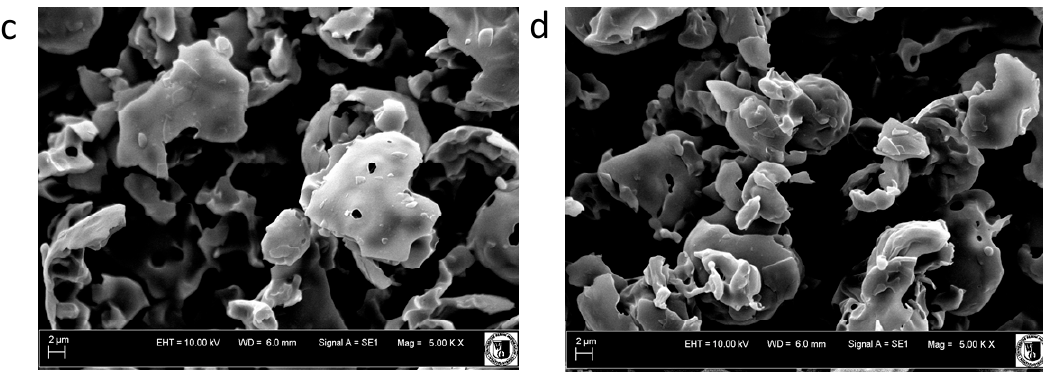
Figure 1. Microstructure of protein and protein-iron complex. View of the formulation at 20 and 10 µ m particle size ( a , b ), protein fragmentation ( c , d ).